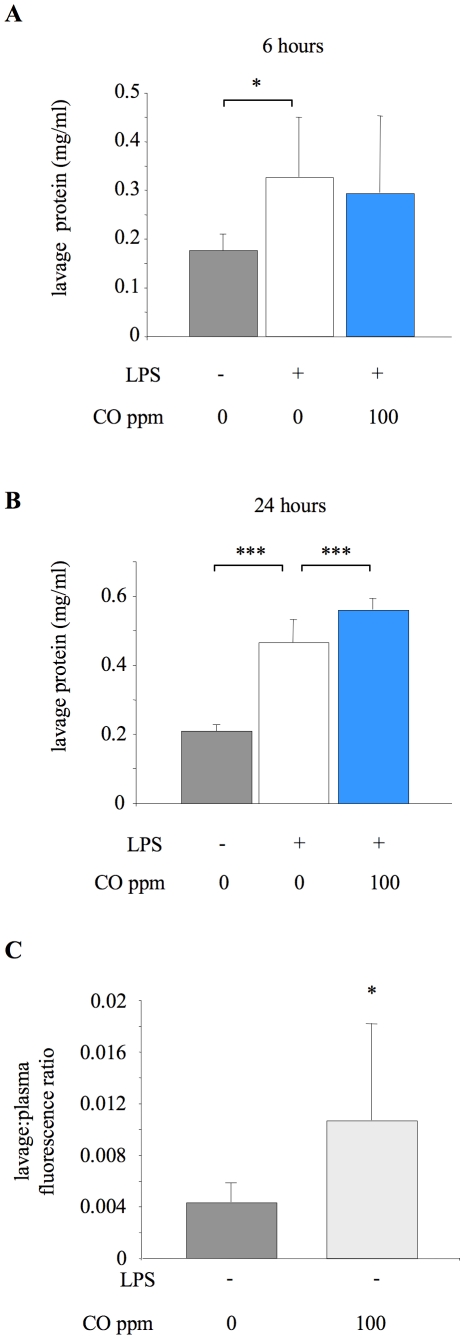
Impact of CO on pulmonary barrier permeability.
A. Lung lavage fluid total protein concentration from untreated animals (no LPS or CO), or mice exposed to 0 or 100 ppm carbon monoxide (CO) for 6 hours after LPS instillation. *p<0.05 vs LPS +0 ppm CO; n = 8 for untreated animals and 15–16 for LPS treated groups. B. Lung lavage fluid total protein concentration from untreated animals or mice exposed to 0 or 100 ppm CO for 24 hours after LPS instillation. ***p<0.001 vs LPS +0 ppm CO; n = 7–8/group. C. Permeability was also assessed in both untreated mice (no LPS or CO) and animals receiving 100 ppm CO alone for 6 hours (no LPS) by determining translocation of a fluorescence-labelled albumin from plasma to alveolar space over a 1 hour period. Data are expressed as a ratio of fluorescence between lavage fluid and plasma. *p<0.05 vs untreated group; n = 6–7.